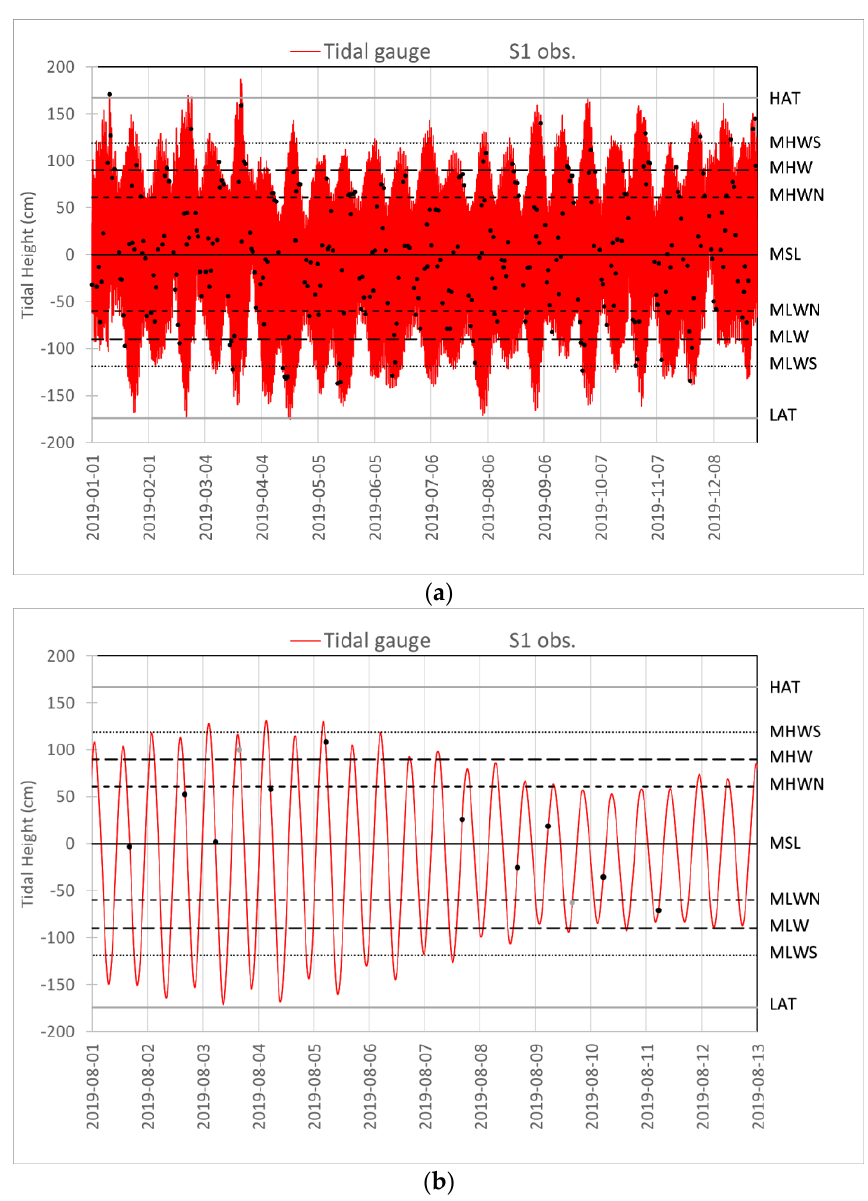
Figure 3. 2019 tidal gauge observations from Hansjordnesbukta (Tromsø) (red line) sampled every 10 min showing ( a ) the tidal range variation for the year 2019 and ( b ) tidal height observations during one S1 repeat cycle 1 – 12 August 2019. Tidal heights at Sentinel-1 acquisition times (see Table 1) are indicated as black dots. Tidal reference levels are indicated on the right. Observations in gray in ( b ) were filtered out because of the steep incidence angle (original tidal data © Kartverket [12]).